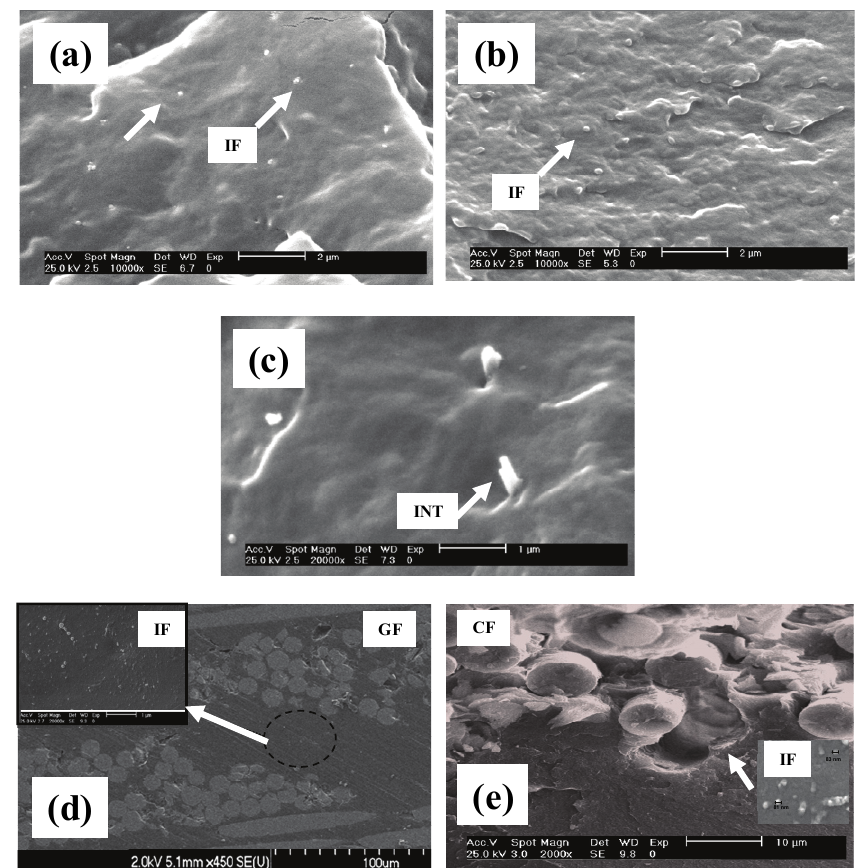
(1.0 wt.%); ( c ) iPP/INT-MoS 2